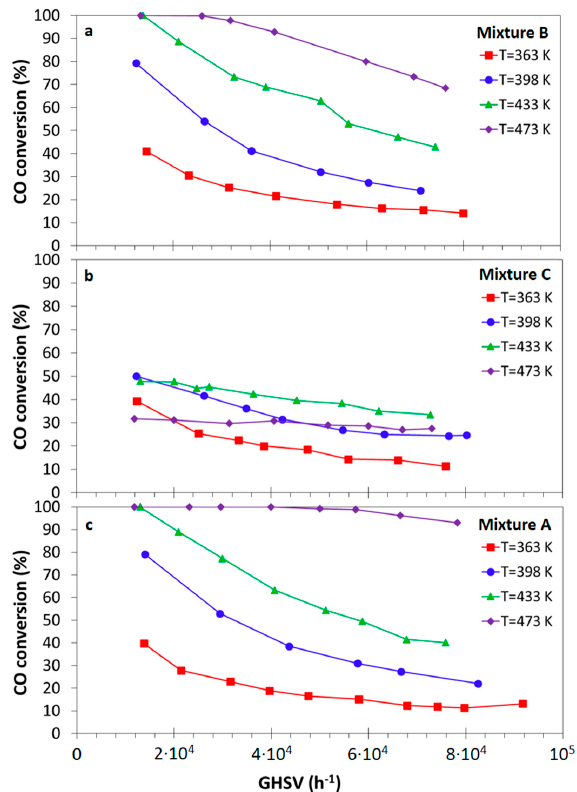
Figure 7. CO conversion for the feed load tests carried out for mixtures ( a ) B, ( b ) C, and ( c ) A tested on the microreactor functionalized with Au@D/TiO 2